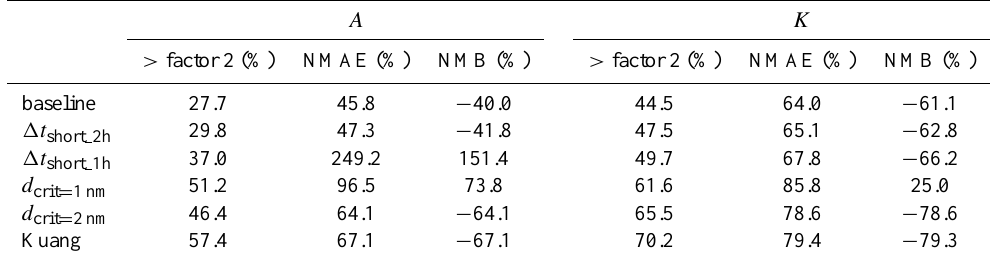
Table 5. Performance metrics for the different analysis set-ups when estimating the nucleation factor A for activation events and factor K for kinetic events. The columns show the percentage of analysed events for which the estimate is not within a factor of two of the simulated rate ( > factor 2), the normalised mean absolute error (NMAE) and the normalised mean bias